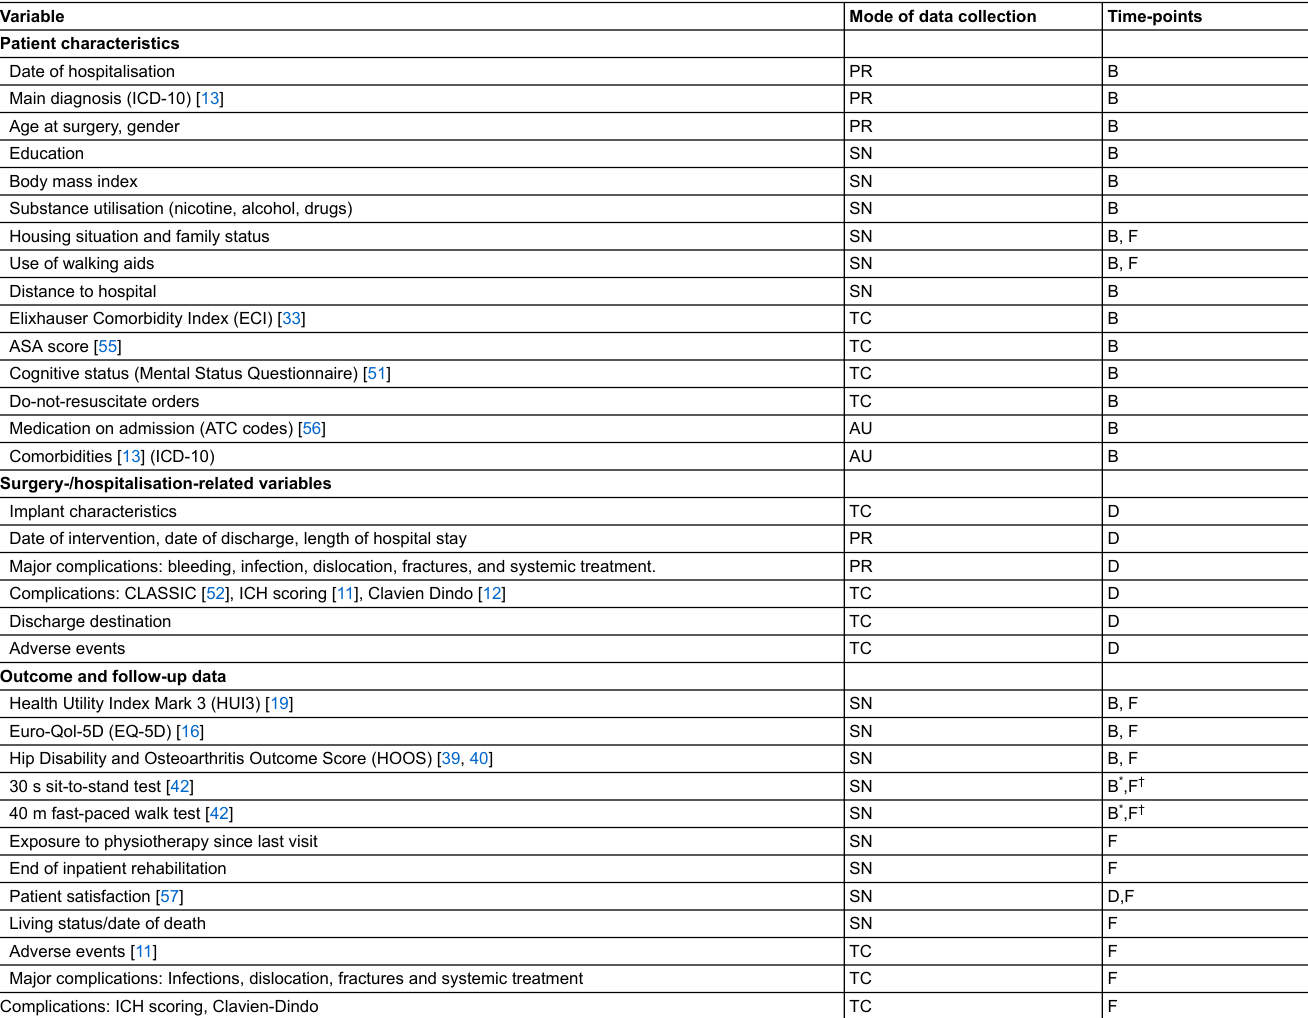
Table 3: Patient-related variables to be collected with mode of collection and time-points.